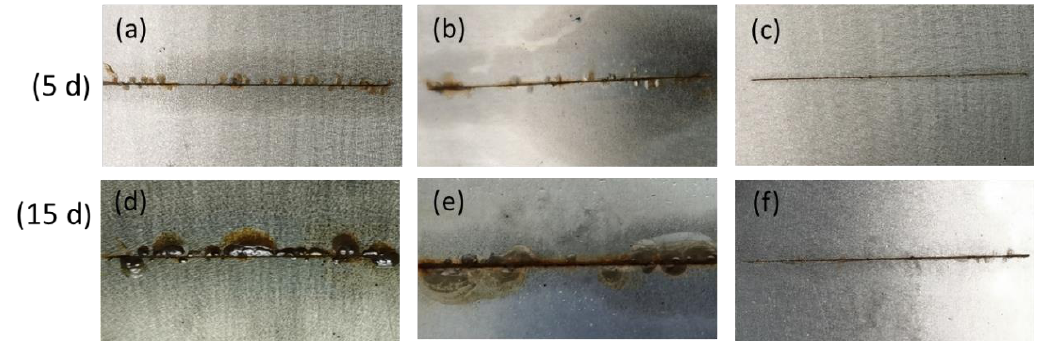
Figure 10. The visual picture of the neat WEP ( a , d ), MoS 2 /WEP ( b , e ) and MoS 2 -APTES/WEP ( c , f ) samples after 5 and 15 days.